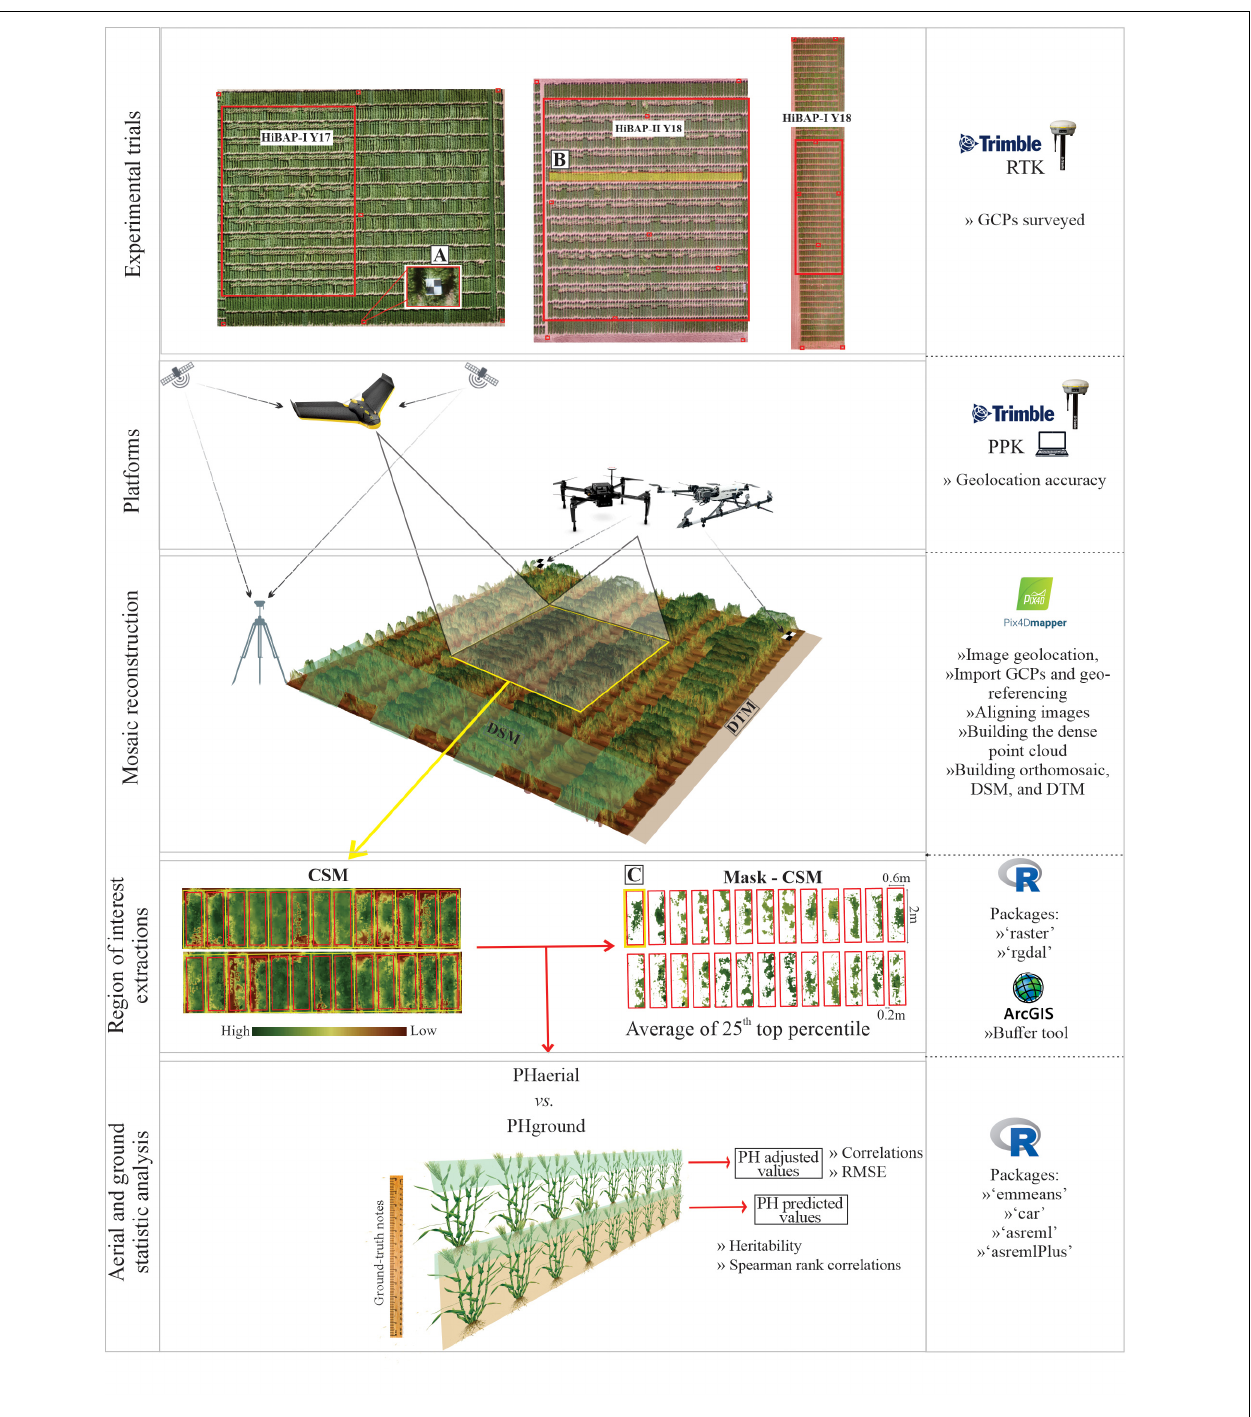
FIGURE 1 | Phenotyping workflow for estimation of plant height (PH) using Plat FW and Plat MR (UAVs) platforms (PHaerial) used in north-west Mexico during the 2017 and 2018 growing cycles. PHground, ground-truth measurements; DTM, digital terrain model; DSM, digital surface model; CSM, crop surface model. (A–C) are GCPs design, locality of the profile selected, and cropped area with the mask of CSM as the top 25th percentile pixels value, respectively.